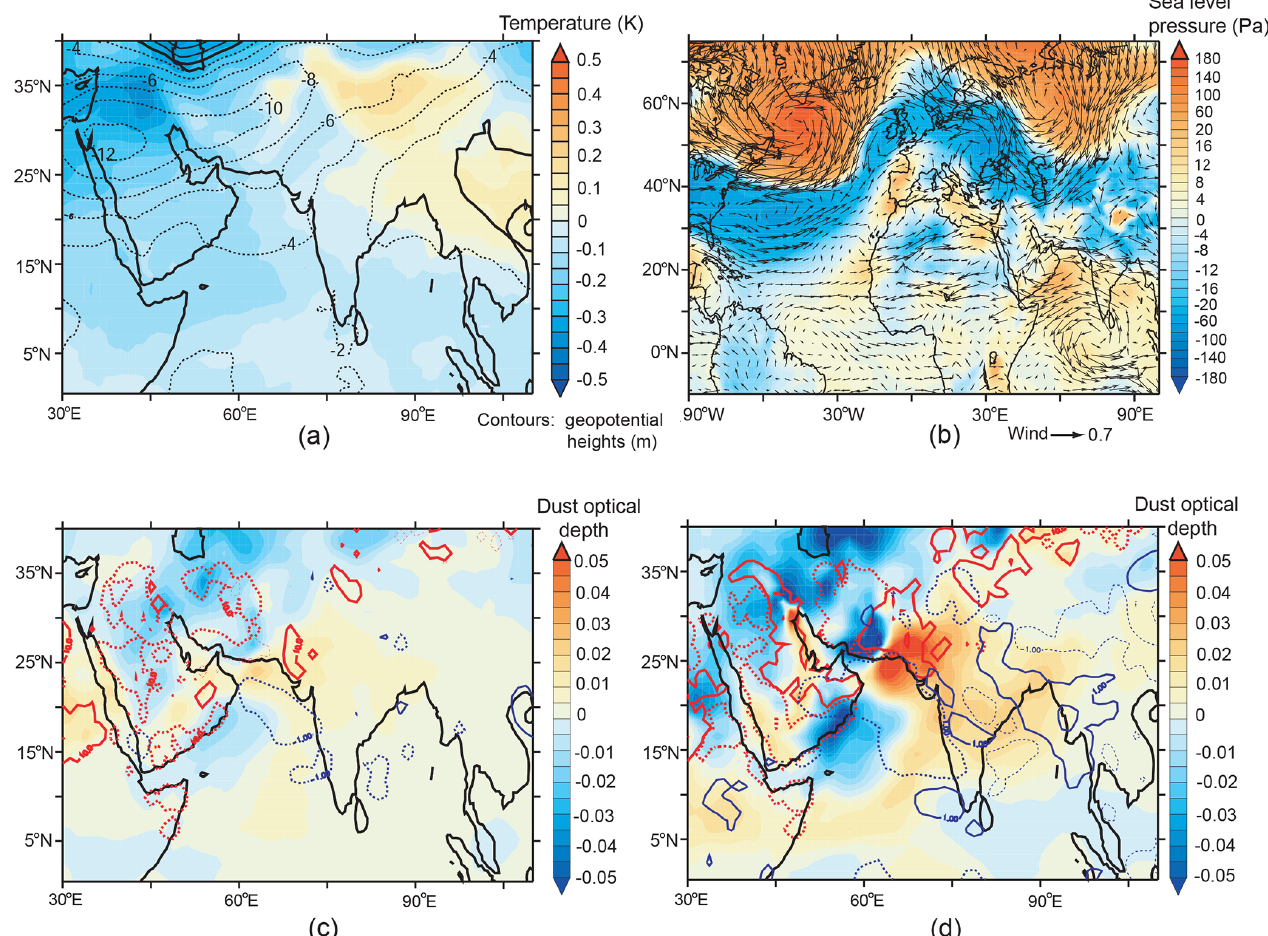
Figure 10. Differences between the CESM NAtl and CESM Ctrl simulations for (a–c) May–September. (a) Shading and contours indicate differences in temperature and geopotential height, respectively, at the 200hPa pressure level. (b) Shading indicates a difference in sea level pressure, and the arrows indicate a difference in wind vectors at the 850hPa pressure level. (c) A difference in the dust optical depth over the northern Indian Ocean and surrounding regions is shown using shading. The thick red contours enclose the regions where the dust emission flux difference is greater than 10mgm 2 d − 1 , and the thin blue contours enclose the regions where the precipitation difference is greater than 1mmd − 1 . Panel (d) is the same as panel (c) but for the month of June. For all contours, positive values are shown using solid lines and negative values are shown using dashed